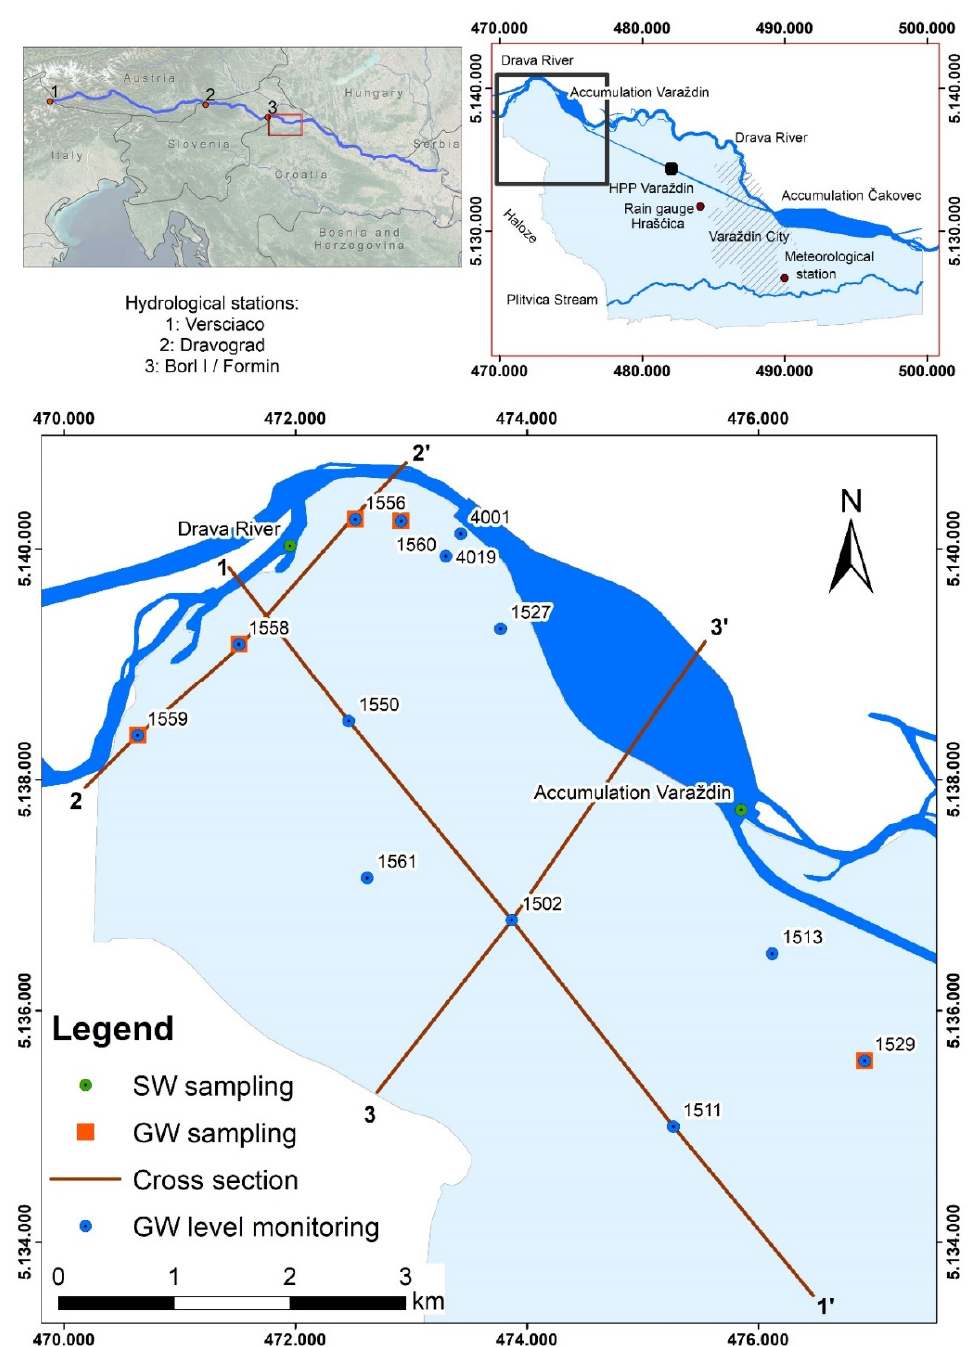
Figure 1. Geographical position of the study area with locations of observation wells used for groundwater level monitoring and sampling sites for surface water and groundwater. The transects 1–1’, 2–2’, and 3–3’ correspond to the representative hydrogeological cross-sections shown in Figure